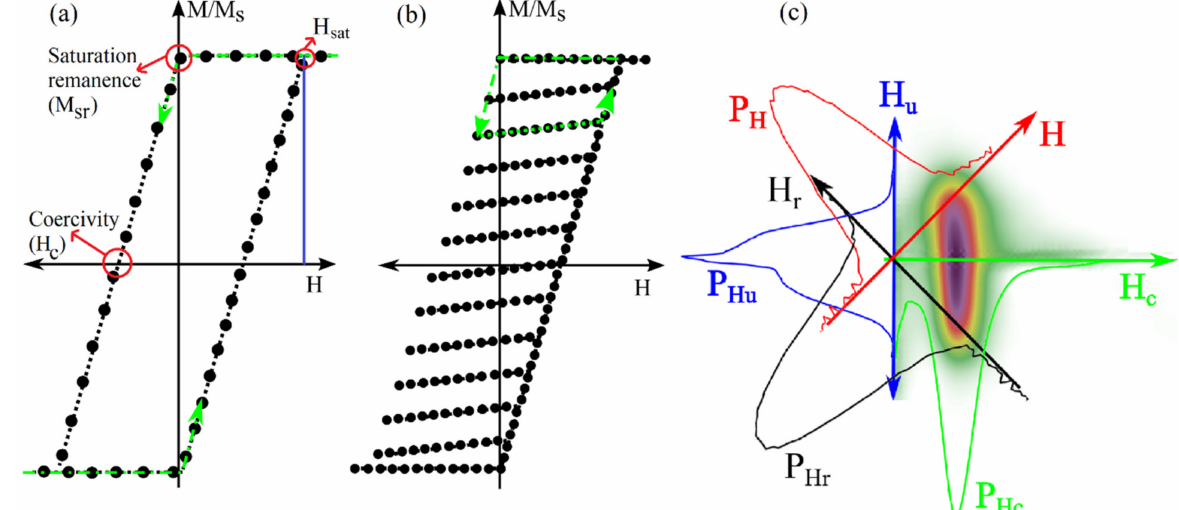
Figure 2. Schematically depicting the hysteresis loop method ( a ) and the FORC method ( b , c ), where ( b ) is the FORC data collection and ( c ) is a FORC heat-map. In subfigures ( a , b ), the green arrows show the data acquisition direction. In subfigure ( c ), the red distribution is the projection of the FORC heat-map on the applied field (H), the blue distribution is the projection of the FORC heat-map on the interaction field axis (interaction field distribution), the black distribution is the projection of the FORC heat-map on the reversal field (Hr), and the green distribution is the projection of the FORC heat-map on the coercivity axis (coercivity distribution). Figure adapted from